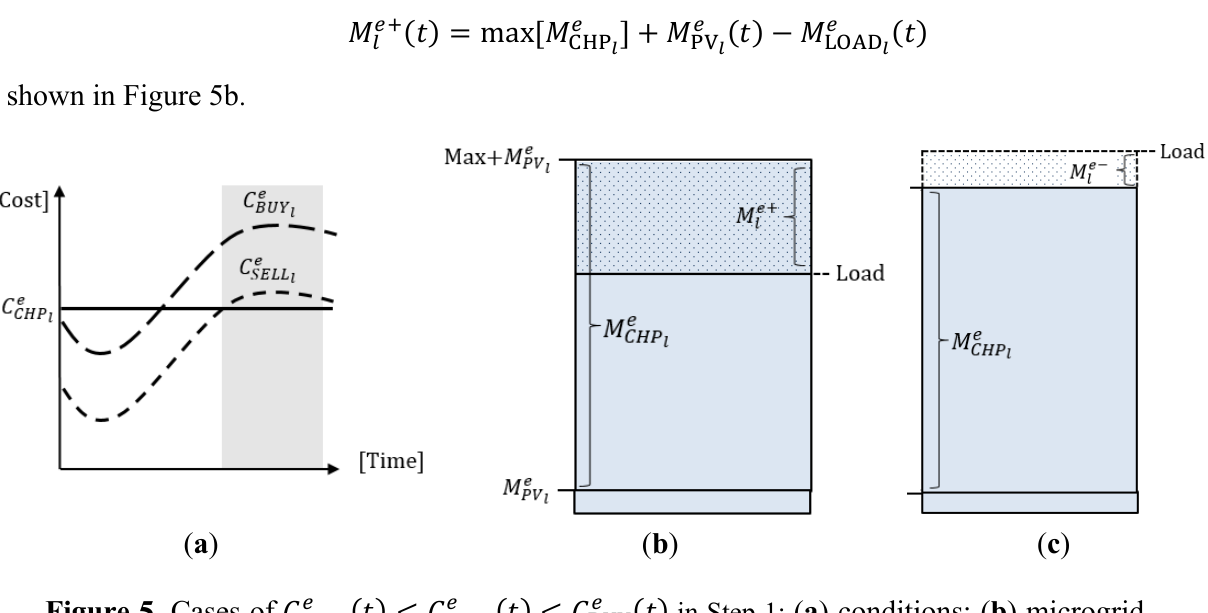
(cid:2887)(cid:2892)(cid:2900) (cid:3287)